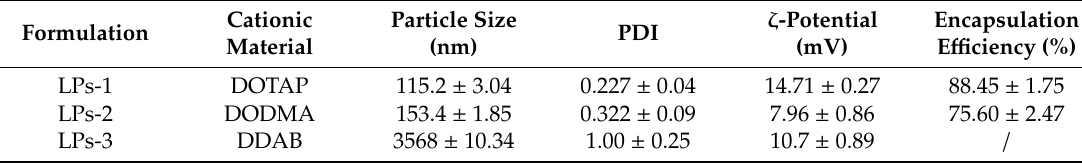
Table 1. The optimum formulations for preparing LPs ( n = 3).